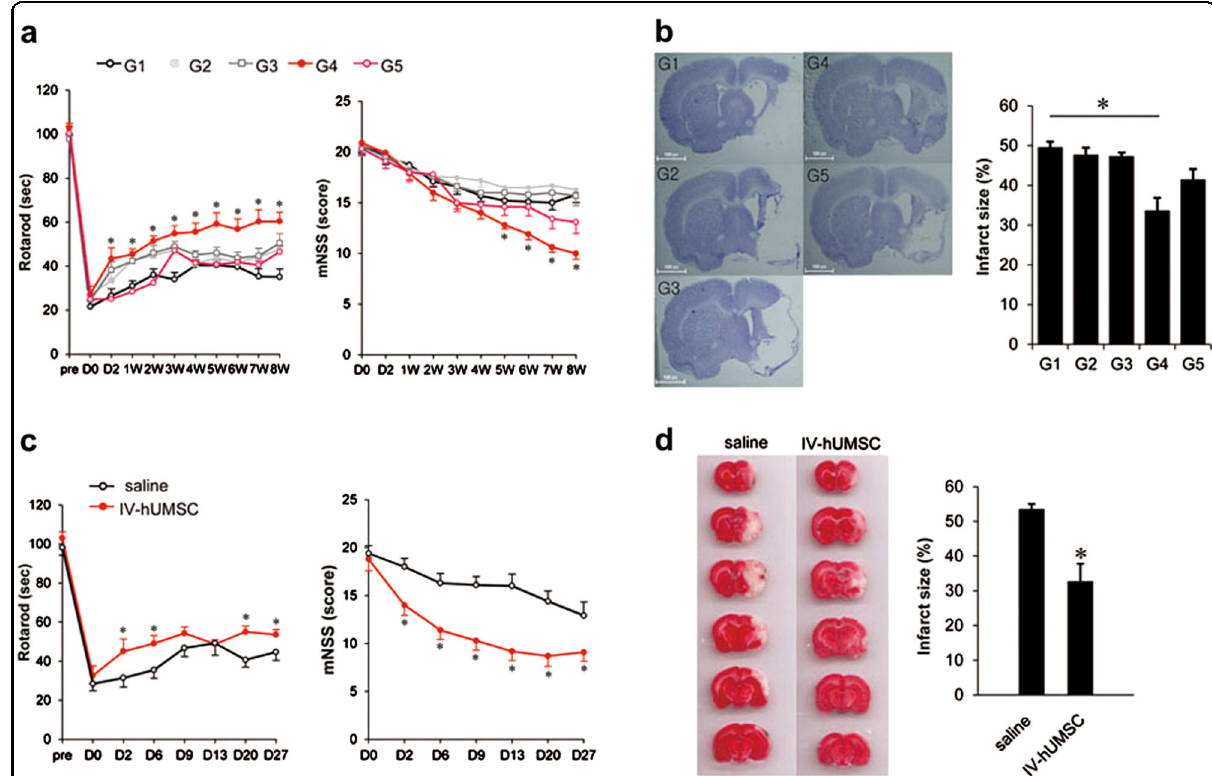
Fig. 1 Functional tests and infarct size of MCAo rats treated with IV-hUMSCs. a Rotarod test (left panel) and mNSS (right panel) test in MCAo rats with various treatment paradigms of IV-hUMSCs ( n = 10 in each group). D0 represents the day of MCAo induction in rats. The data were analyzed using the mixed ANOVA test. * p < 0.05 between G1 group and G4 group. b Infarct size using Cresyl violet staining at 8 weeks post MCAo in rats treated with IV-hUMSCs at various cell doses and delivery time points ( n = 7 for each group). c Rotarod test (left panel) and mNSS (right panel) test of an independent study of IV-hUMSCs at 1 × 10 6 cells at 24 h post MCAo ( n = 10 in each group). The data were analyzed using the mixed ANOVA test. d Measurement of infarct size using 2, 3, 5-triphenyltetrazolium chloride (TTC) staining at 72 h post MCAo in an independent study of IV-hUMSCs at 1 × 10 6 cells at 24 h after MCAo ( n = 5 in each group). All data are presented as the mean ± SEM. * p <